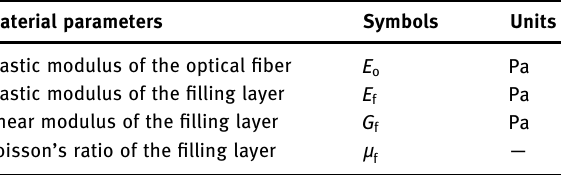
Table 1: Ring tube packaging material parameters Material parameters